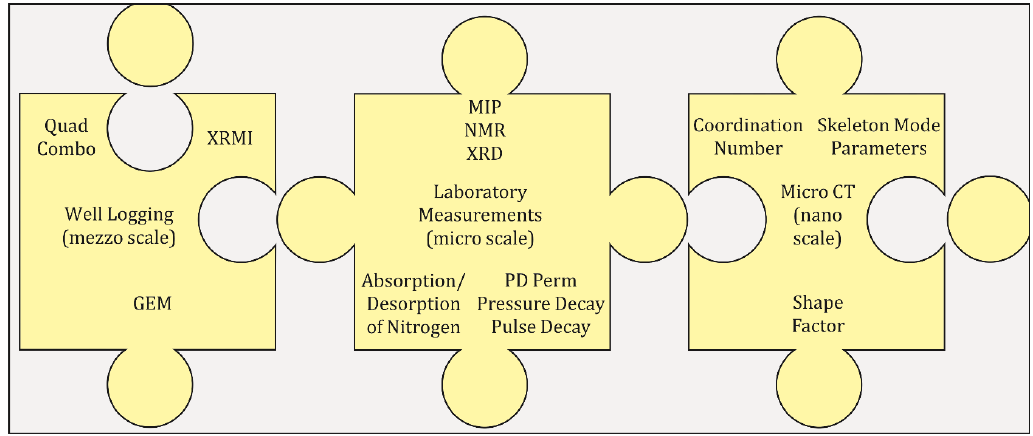
Figure 2. Integrated well logging and laboratory analyses workflow elaborated to improve the rock typing and pore network characterization.